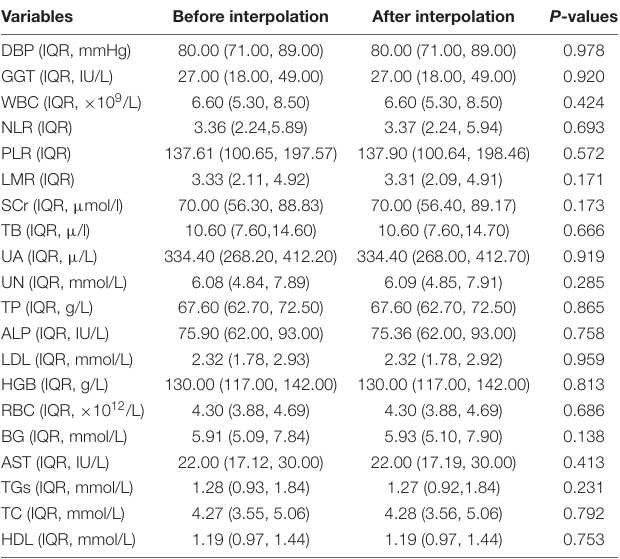
TABLE 1 | Comparison of continuous variables in the training and internal validation sets before and after multiple imputation. Variables